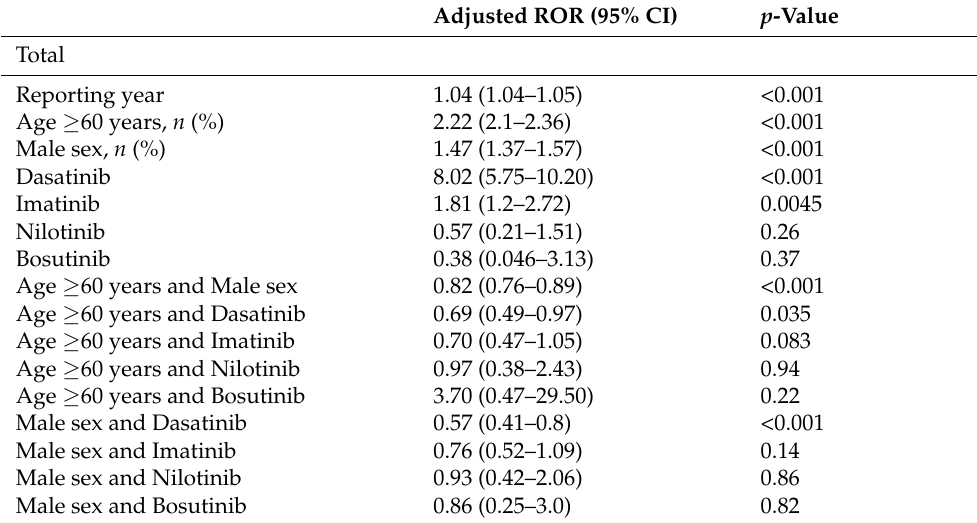
Table 2. Multiple logistic regression analysis.